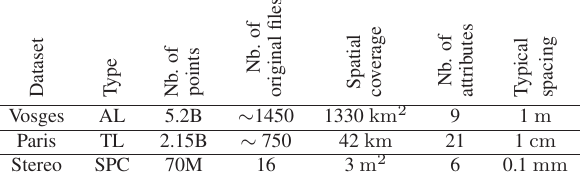
Table 3: Creating and indexing patches for the test data